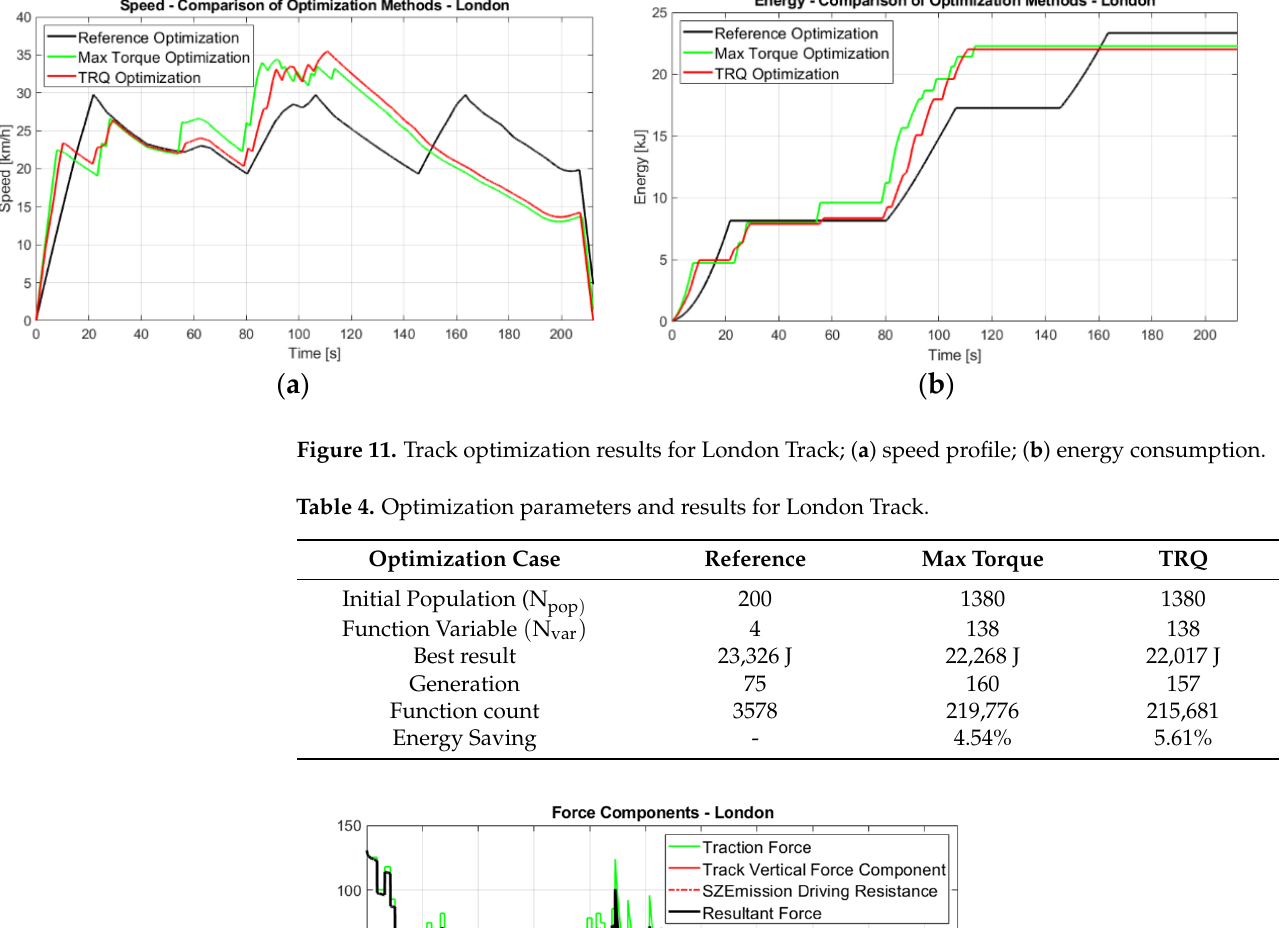
Figure 11. Track optimization results for London Track; ( a ) speed profile; ( b ) energy consumption.